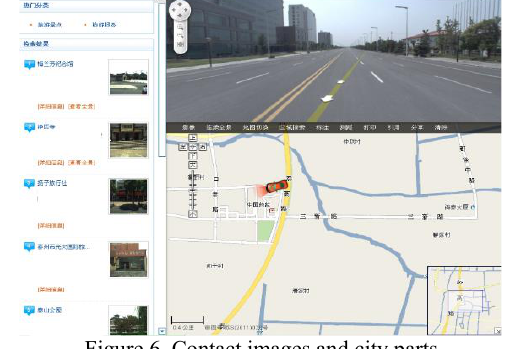
Figure 6. Contact images and city parts